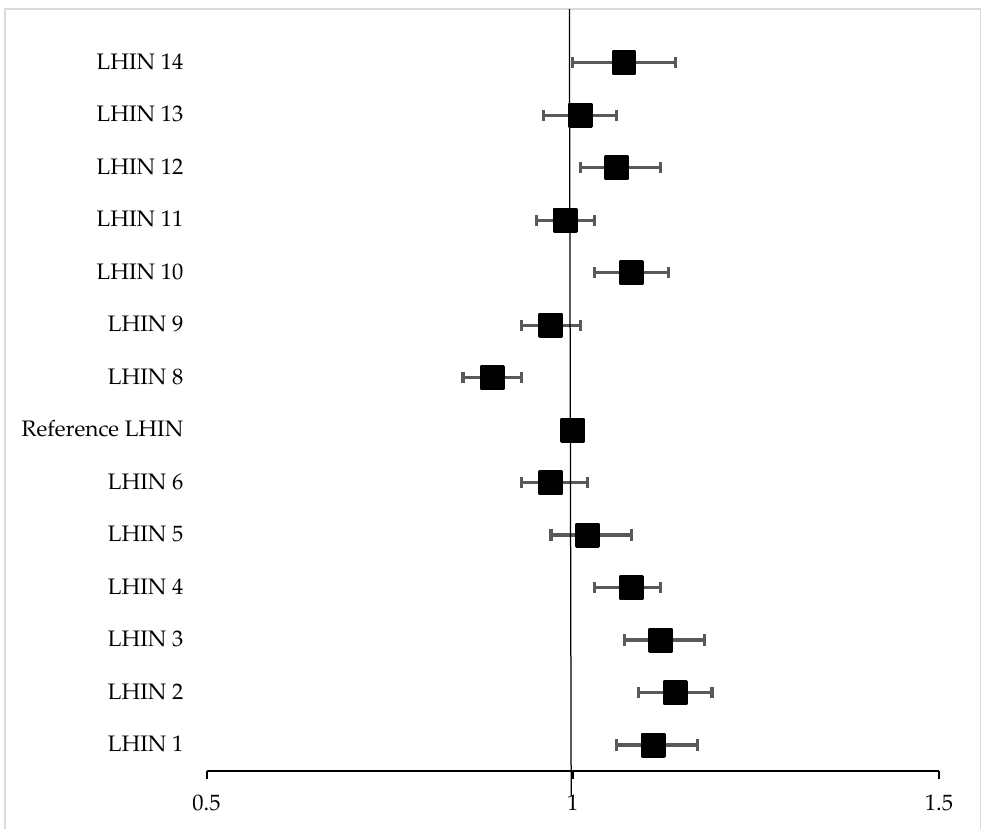
Figure 5. Adjusted hazard ratios for cancer-specific mortality by LHIN. This graph shows the HRs for cancer-specific mortality calculated by Cox modeling and adjusting for patient age, sex, income quintile, rurality index, distance to the nearest hospital, stage, histology, co-morbidity status, timeliness of care, and access to specialty assessment. After adjusting for these variables, the performance of some LHINs improved, and while there was less disparity amongst LHINs, significant differences remained.